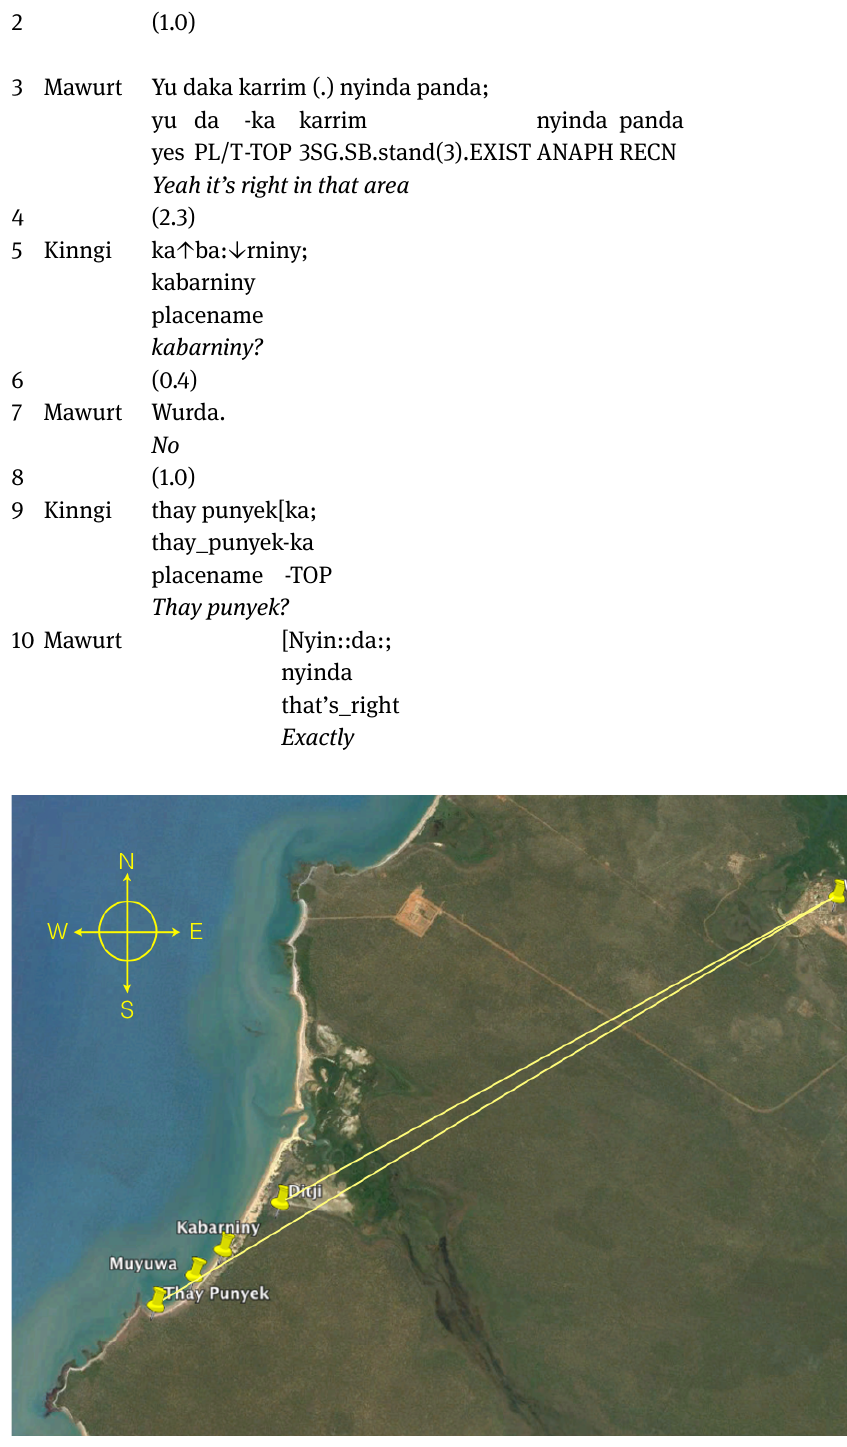
Figure 9: At roughly seventeen kilometres from where Mawurt and Kinngirri are sitting, the locations Ditji , Muyuwa , Kabarniny and Thay Punyek lie within 2° of